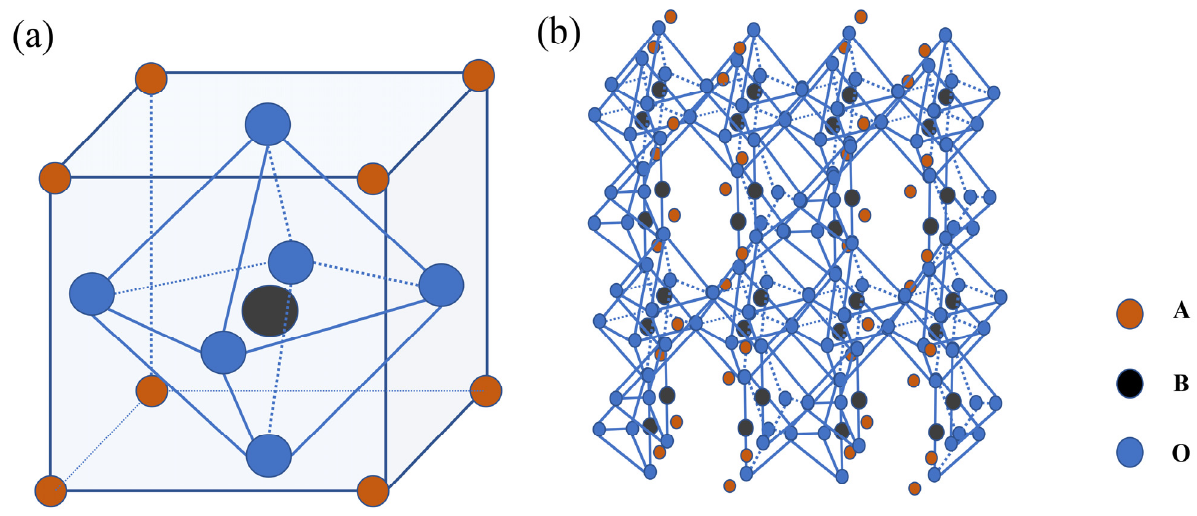
Figure 1. ( a ) P-SCO and ( b ) BM-SCO structures of strontium cobaltite.